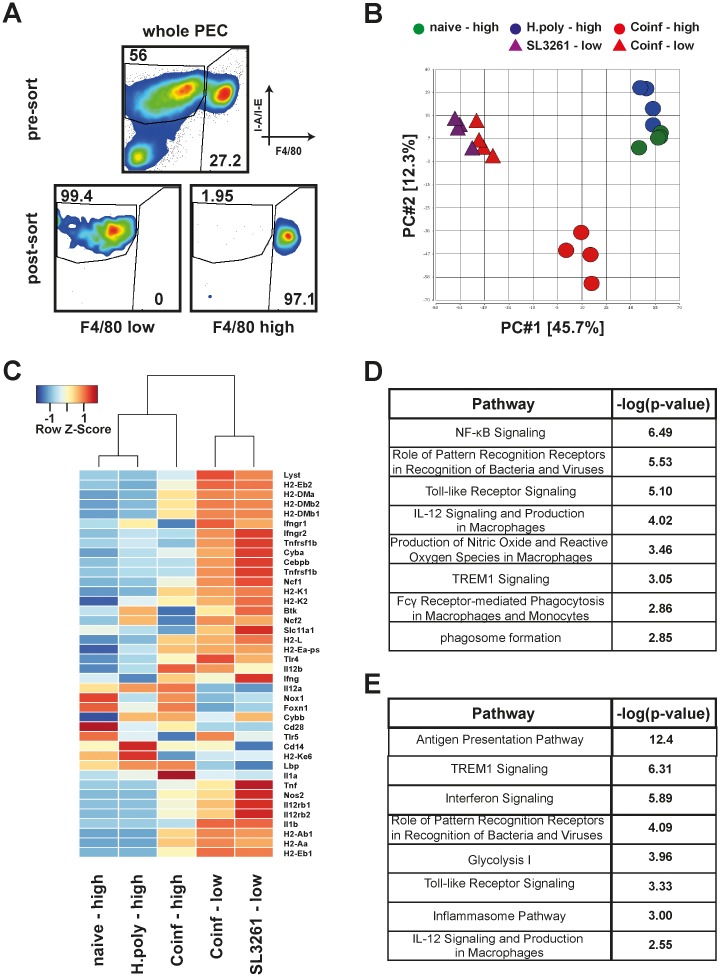
Microarray analysis of MΦ populations from single and co-infected animals.A) Representative dotplots depicting unsorted and sorted MΦ populations. Tissue resident derived, F4/80high and monocyte-derived F4/80low MΦ were identified as lineage negative (Ly6G-, TCRβ-, SiglecF-, CD19-) CD115+ F4/80 high or low, respectively, and sorted by fluorescence activated cell sorting reaching purities of >96%. B) Principal component analysis of global gene expression in F4/80high (circle) or F4/80low (triangle) MΦ from naive (green), single H. polygyrus (blue), SL3261 (purple) or co-infected (red) animals. C) Hierarchical clustering and heatmap of genes associated with resistance to SL3261. D) Selected canonical pathways determined by IPA, significantly enriched for DE genes in pairwise comparisons of F4/80low and F4/80high MΦ from co-infected animals. E) As D) in pairwise comparisons of F4/80high MΦ from co-infected animals compared to single H. polygyrus infected animals.